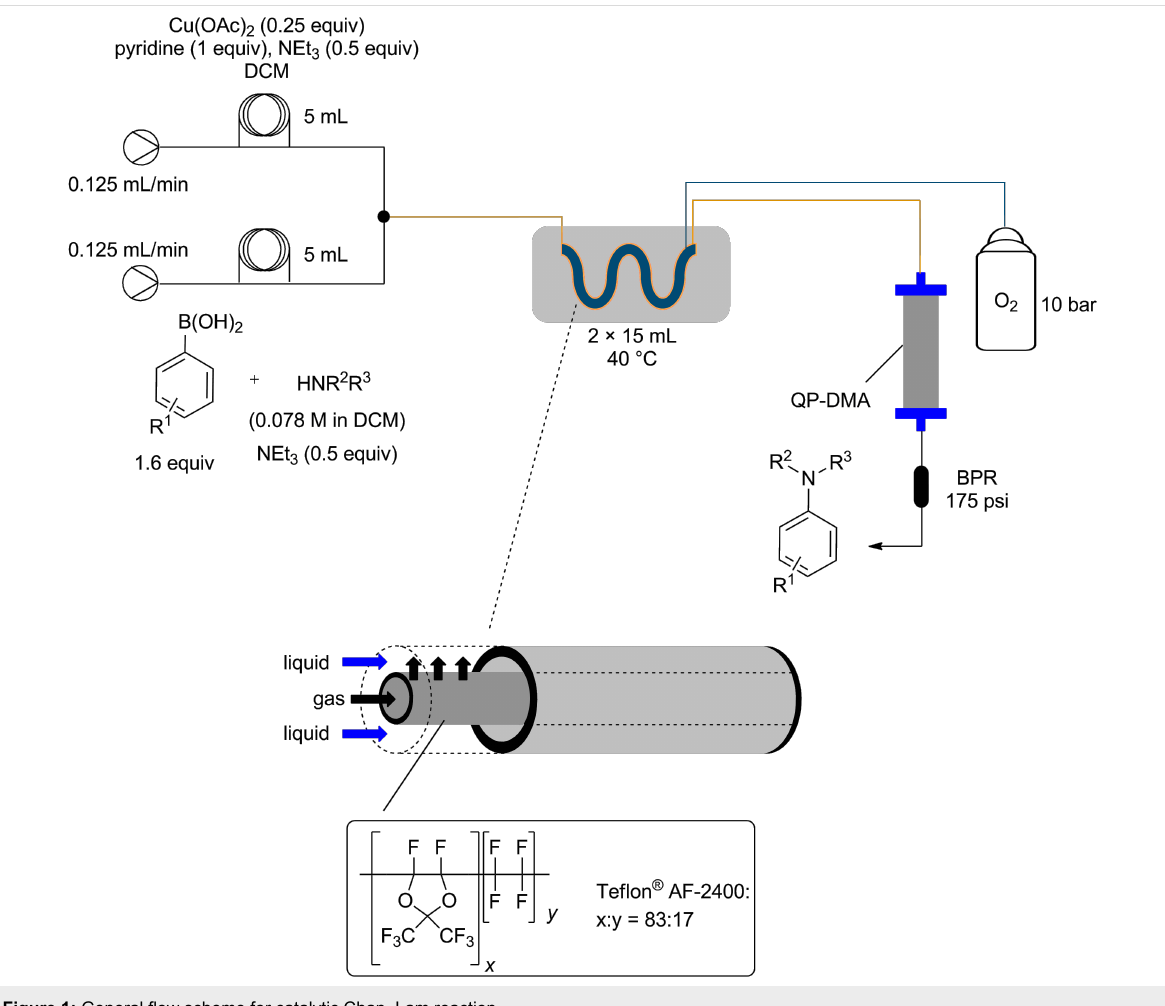
Figure 1: General flow scheme for catalytic Chan–Lam reaction.